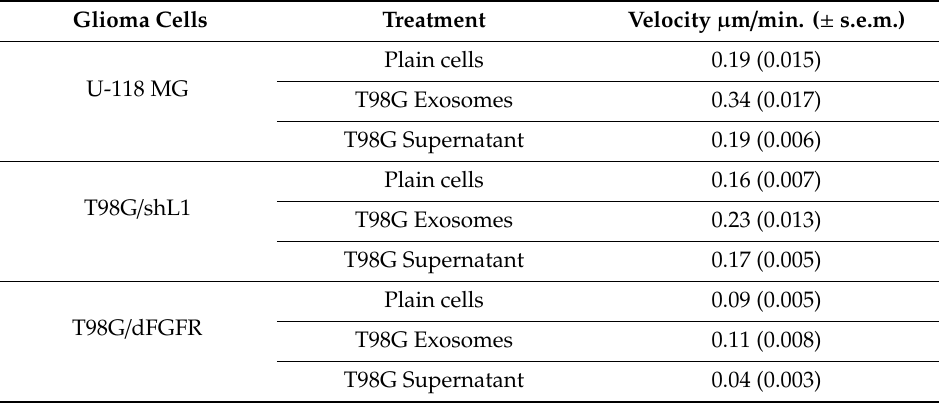
Table 1. Cell motility rates with exosome vs. supernatant